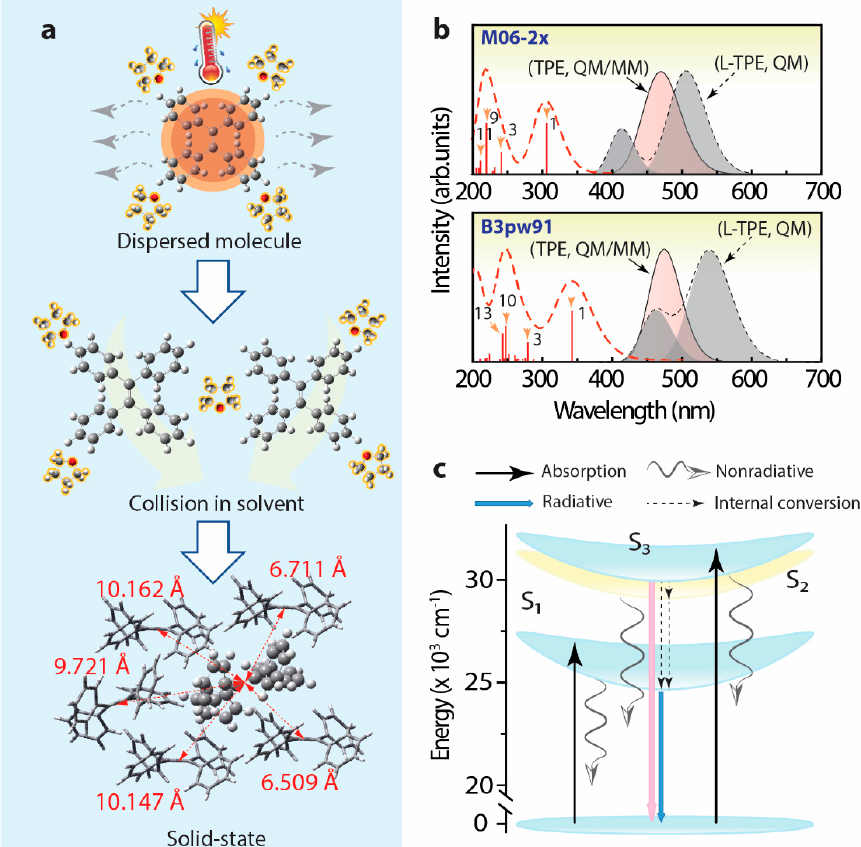
Figure 10. ( a ) Schematic diagram to display the interactions around TPE during the transition from a dissolved state to an aggregated solid state (the crystal structure data originated from CCDC 1521874 [74]), ( b ) calculated UV − Vis spectrum and emission spectrum of L-TPE based on TD-DFT calculations (QM, dash lines, emission spectrum summing up the separated S 1 → S 0 , and S 3 → S 0 emission bands, halfwidth = 0.15 eV), as well as the calculated emission spectra of TPE in crystal based on QM/MM calculation (solid line, halfwidth = 0.15 eV), ( c ) schematic diagram to explain the energy transfer mechanism of TPE in a dissolved state.